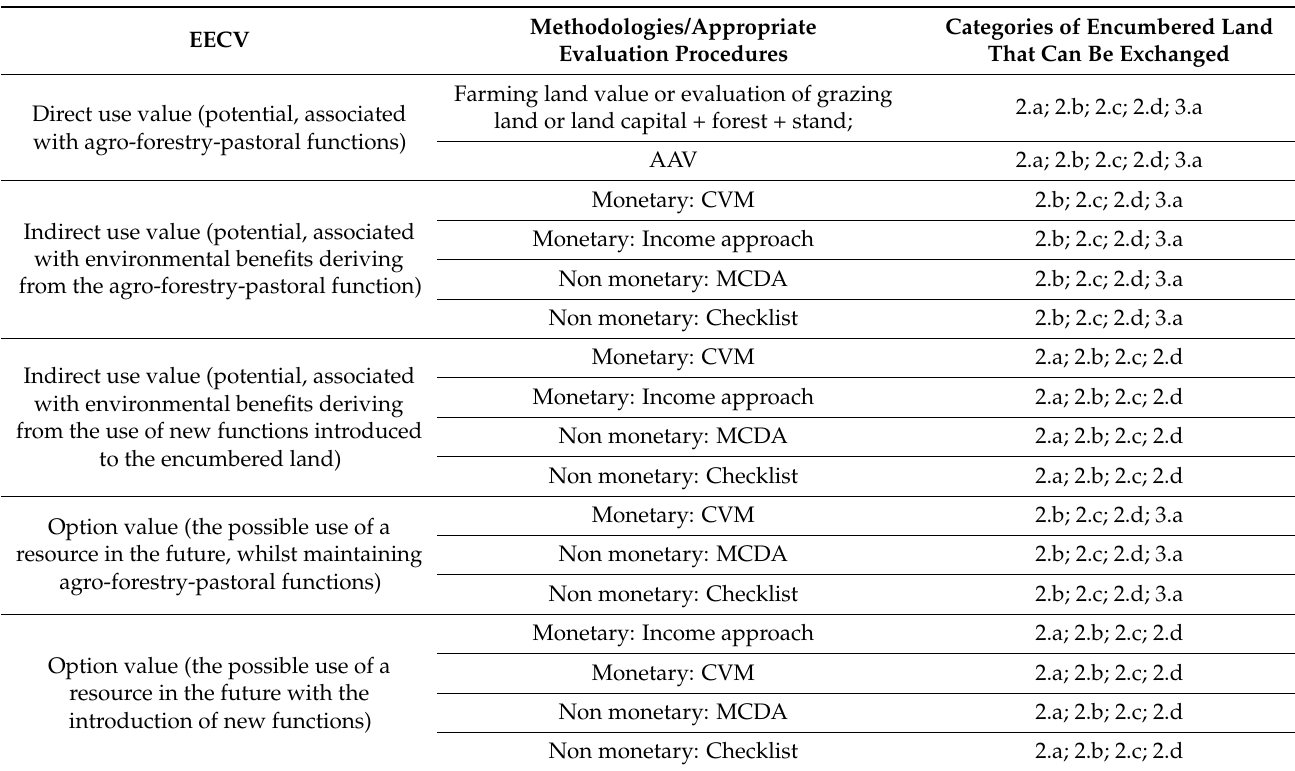
Table 1. Exchange categories for areas encumbered by civic uses and the appropriate evaluation procedures.